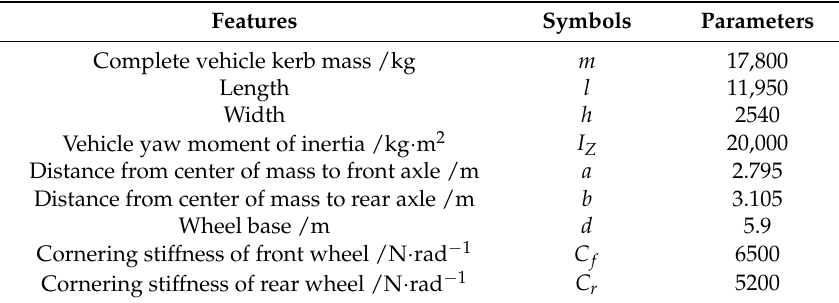
Table 1. Vehicle parameters.